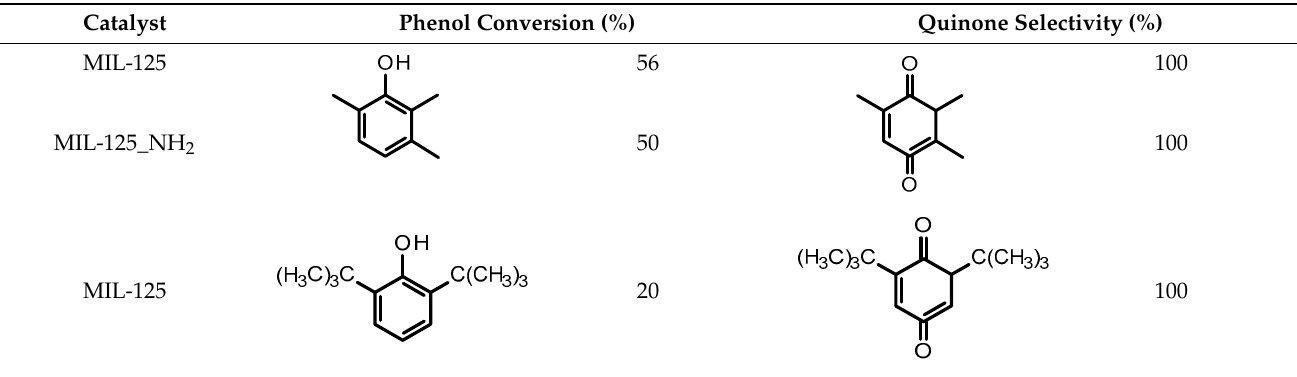
MIL-125 20 100 MIL-125 20 100 20 MIL-125 20 MIL-125 MIL-125 20